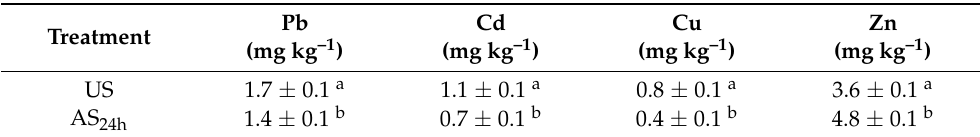
Table 2. Heavy metal mass fraction in untreated (US) and aerated (AS) slurry. Data are means ( n = 5) ± SE. Treatment